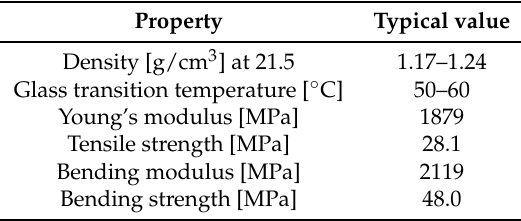
Table 1. Material properties of polyactide